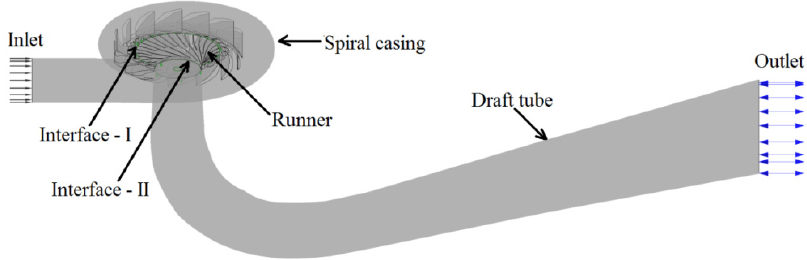
Figure 2. Computational domain for the Francis turbine: Interface ‐ I, connecting the distributor and runner; Interface ‐ II, connecting the runner and draft tube. The interfaces are located at the runner inlet and the runner outlet locations. Exact interface locations can be seen in Figure 1.